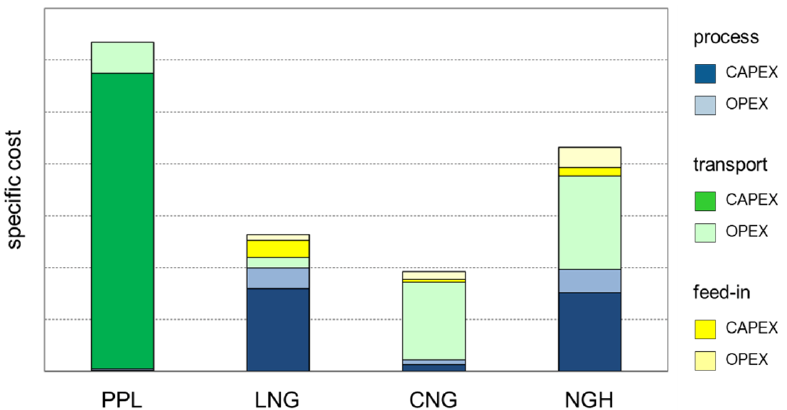
Figure 10. Specific total costs of the transport options pipeline (PPL), LNG, CNG